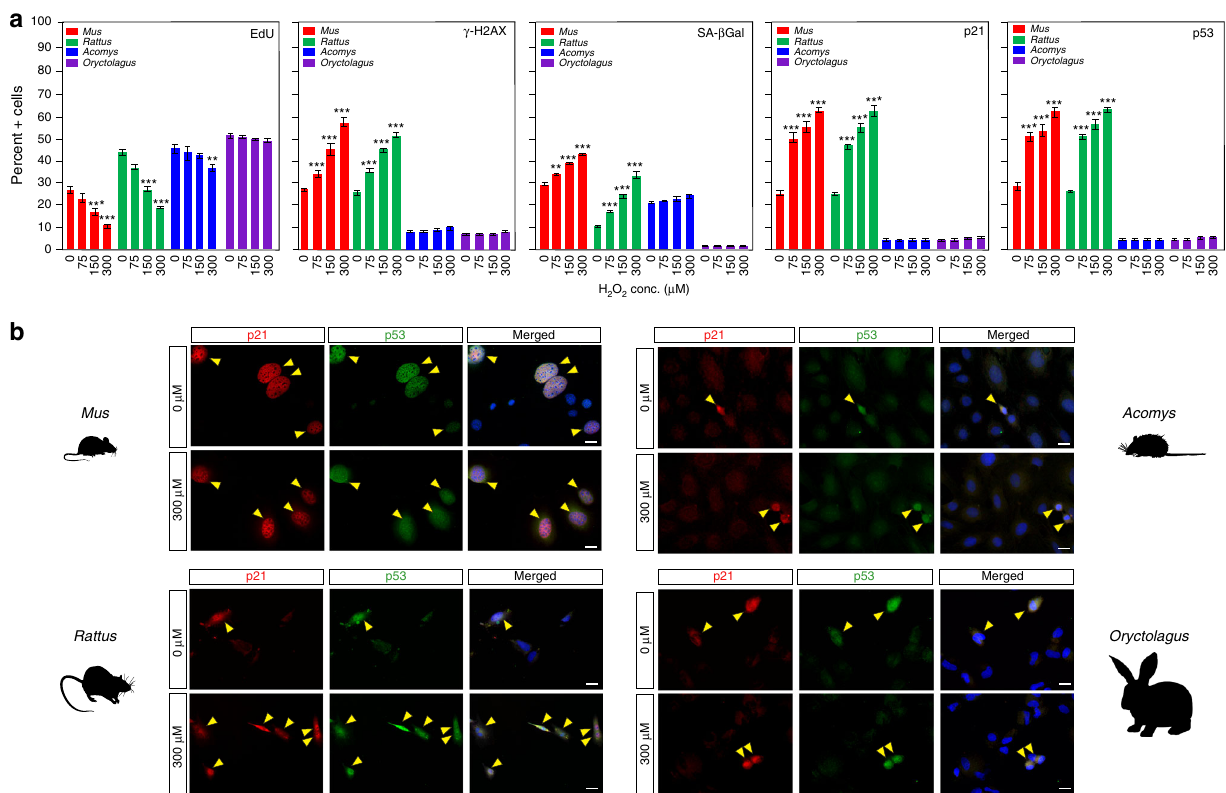
Fig. 4 Fibroblasts from regenerating mammals are refractory to ROS-induced cellular senescence. a , b Fibroblasts from regenerating ( Acomys and Oryctolagus ) and non-regenerating mammals ( Mus and Rattus ) treated with increasing concentrations of H 2 O 2 (0 μ M-control, 75 μ M, 150 μ M and 300 μ M) for 2h and then cultured for 48h in complete media ( n = 4/species). a H 2 O 2 induced a signi fi cant decrease in the percentage of proliferating cells (EdU + ) in Mus at 150 μ M (Tukey-HSD, t = 5.95, P <0.0001) and 300 μ M H 2 O 2 (Tukey-HSD, t = 10.04, P <0.0001), as well as in Rattus at 150 μ M (Tukey-HSD, t = 8.25, P <0.0001) and 300 μ M H 2 O 2 (Tukey-HSD, t = 12.88, P <0.0001), a small but signi fi cant decrease in Acomys at 300 μ M H 2 O 2 (Tukey-HSD, t = 4.19, P = 0.0099) and no signi fi cant change a t any H 2 O 2 concentrations in Oryctolagus (Supplementary Table 15). The percentage of senescent cells ( γ -H2AX + , SA- β gal + , p21 + , and p53 + ) signi fi cantly increased in non-regenerating species and were unchanged in regenerating Acomys and Oryctolagus (Supplementary Tables 16 – 19). b Representative fi broblast cultures in panel a double-stained with p21 and p53 showing nuclear localization of these tumor suppressors in response to H 2 O 2. Scale bars = 20 µ m. *** P <0.0001, ** P <0.001, * P <0.05. Error bars = S.E.M. Source data are provided as a Source Data fi